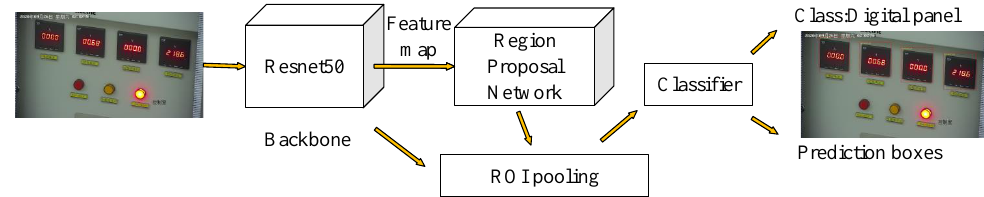
Figure 2. Faster R-CNN regional positioning.